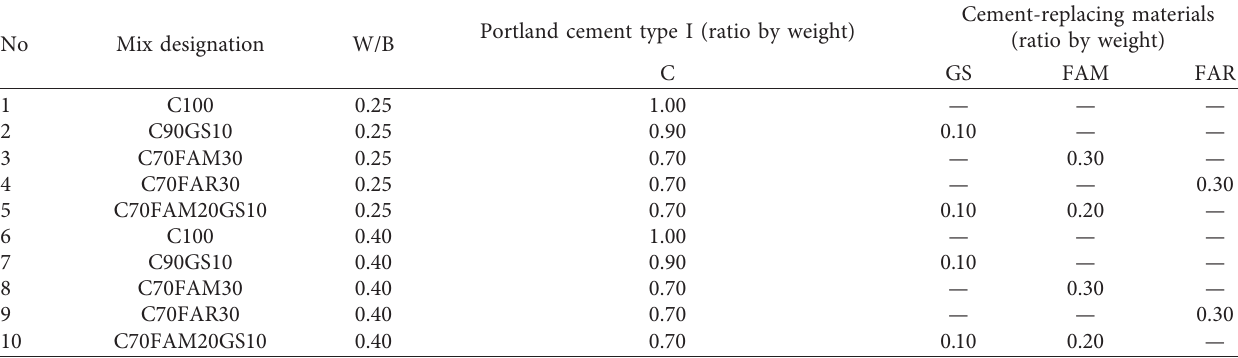
Table 3: Mix proportions of tested paste